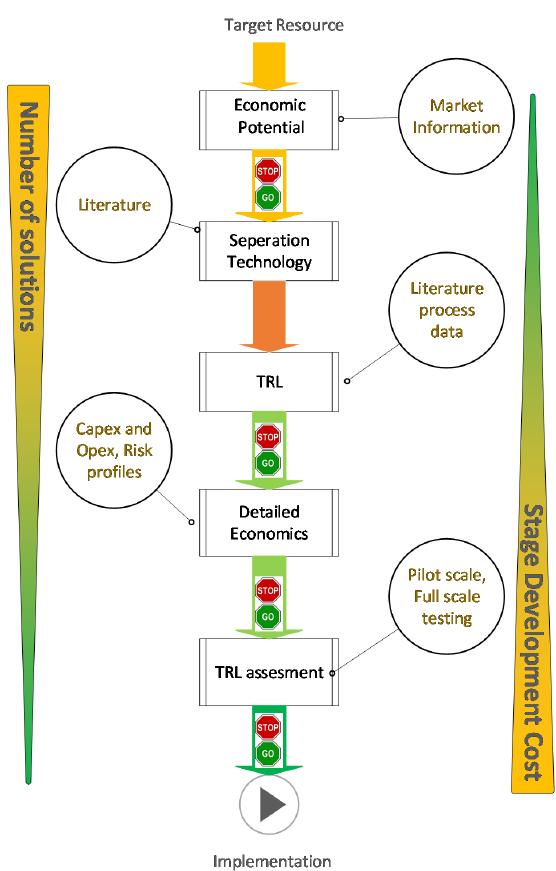
Figure 2. “Plug ‘n’ Play” guideline for identification and development of resource recovery